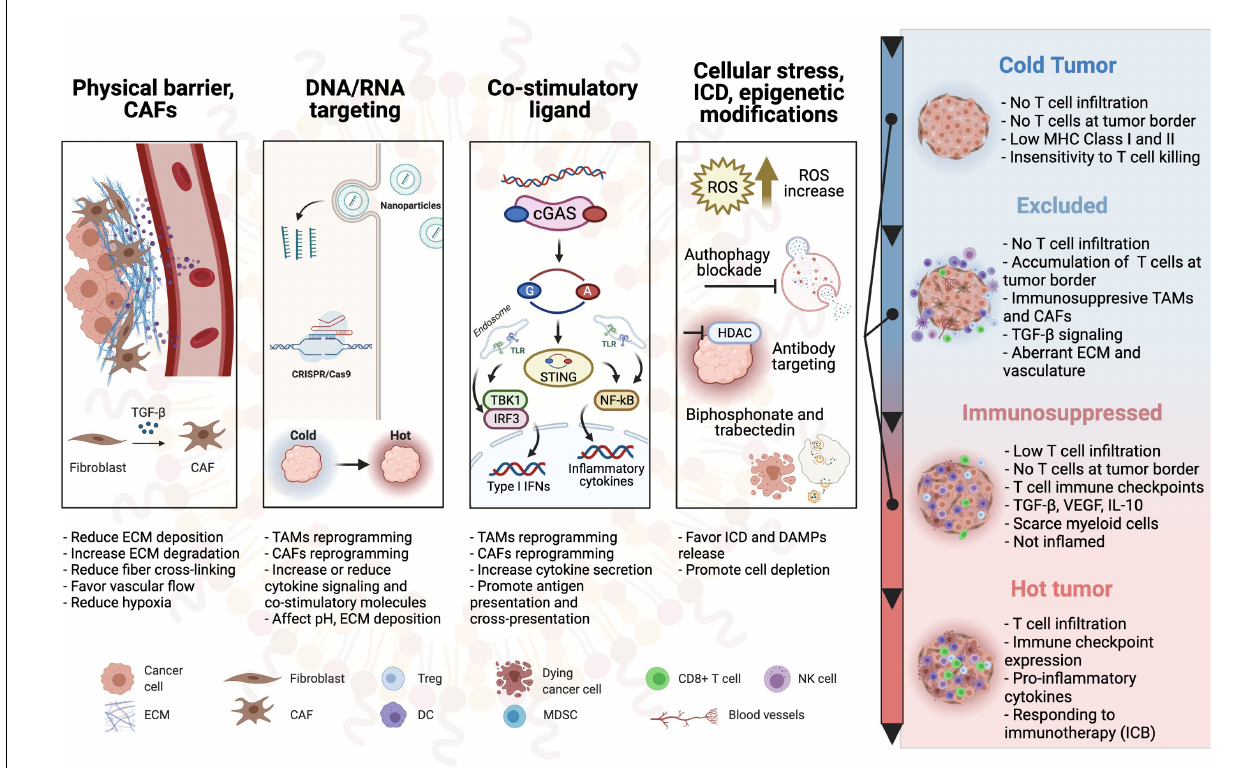
FIGURE 1 | Schematic overview of the nanoparticle-based therapies to turn cold tumors hot. CAF, cancer-associated fibroblast; ECM, extracellular matrix; TAM, tumor-associated macrophage; Treg, regulatory T cell; DC, dendritic cell; TLR, toll-like receptor; MDSC, myeloid-derived suppressor cell; ICD, immunogenic cell death; NK cell, natural killer cell; MHC, major histocompatibility complex; ICB, immune checkpoint